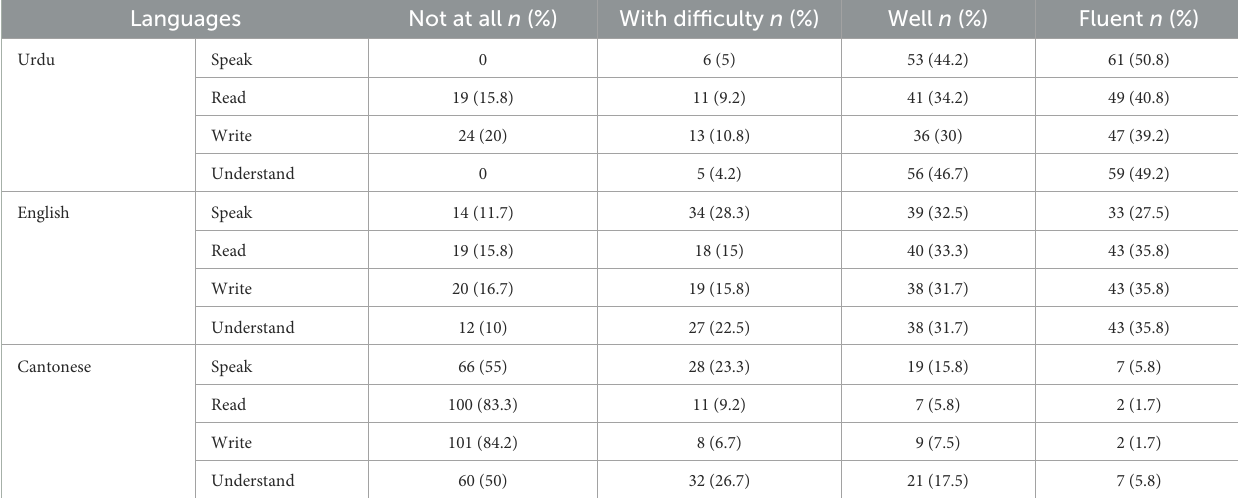
TABLE 2 Language ability of the